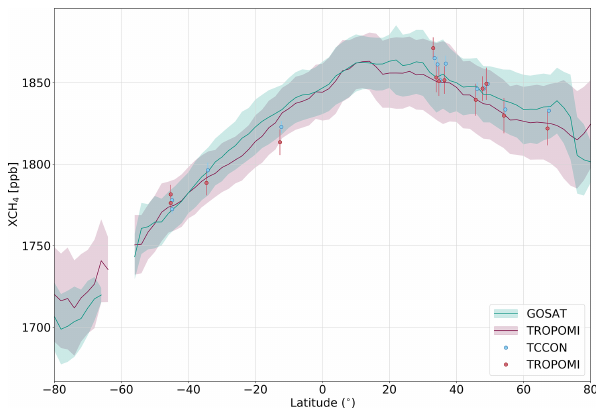
Figure 11. Latitudinal distribution of XCH 4 measured by TROPOMI and GOSAT and the TROPOMI and TCCON colloca- tions over the selected stations for validation in Sect. 4. The shaded bands indicate the scatter (i.e. 1 σ standard deviation) around the